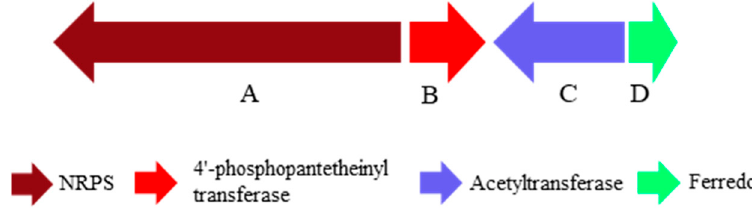
Figure 4. Putative jat gene cluster.